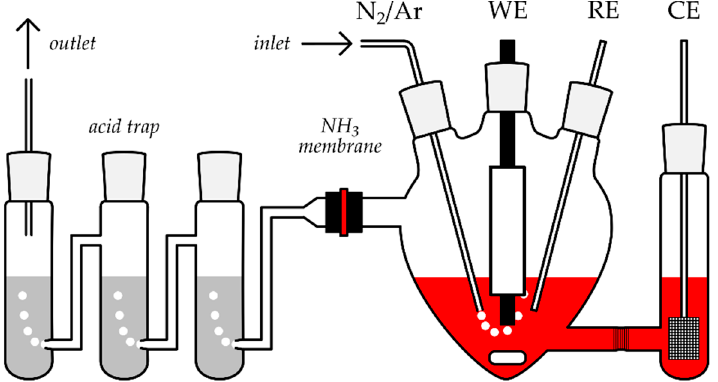
Figure 4. Electrochemical three-electrode setup equipped with an ammonia-selective membrane. A flamed-dried three-necked round-bottomed flask (25 mL) was charged inside a